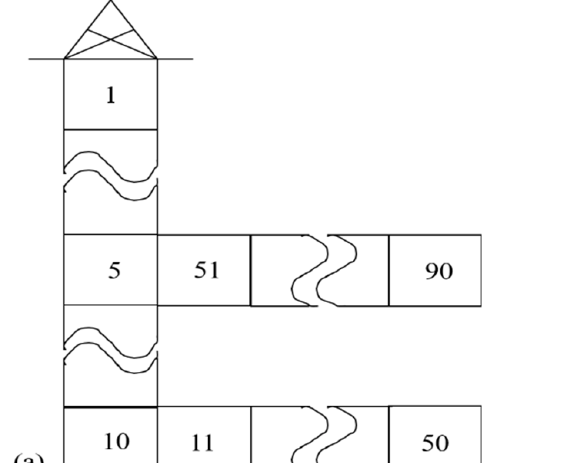
Figure 9. Comparisons of ( a ) gas-producing rate and ( b ) the pressure of a perforated segment from Tang et al.’s coupled reservoir/wellbore simulator and E300. This figure was modified from Figure 4.7 in ref [96].